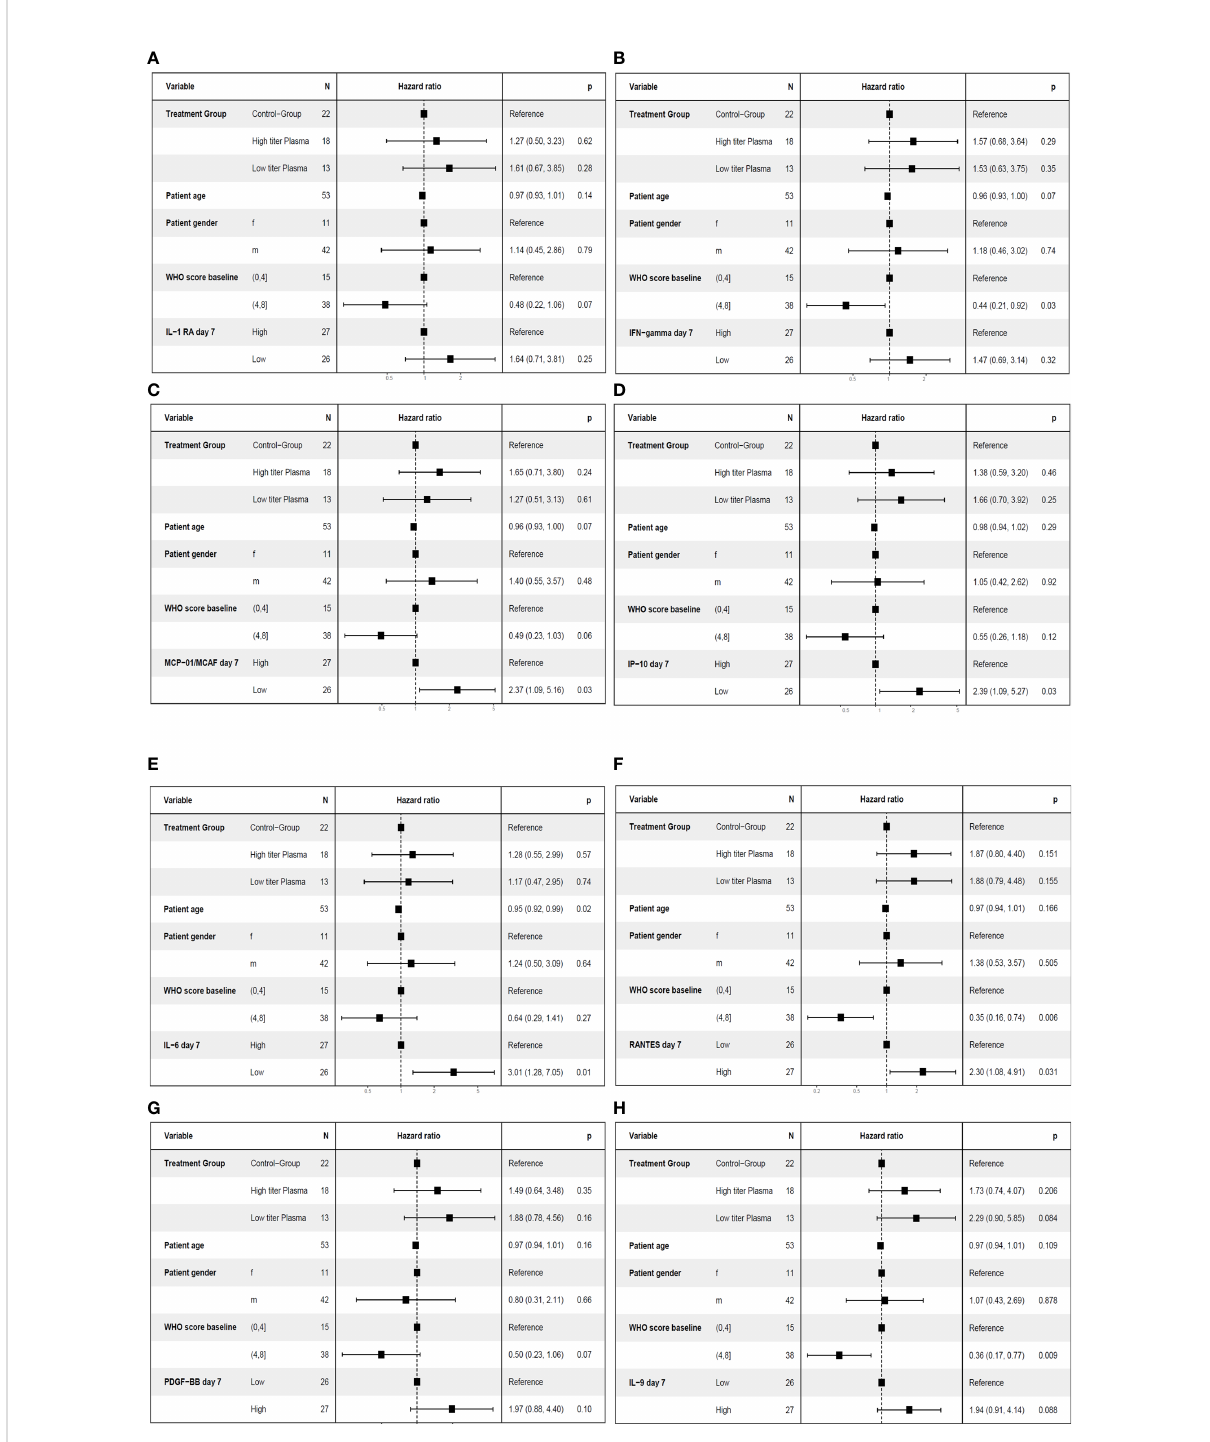
FIGURE 9 Multivariate analyses of the key secondary endpoint time to clinical improvement ( ≤ median vs. > median) including cytokine levels on day 7. The following variables were included in the model: Treatment group (control group, high titer plasma, low titer plasma), age (as continuous variable), gender, baseline WHO Severity Score ( ≤ 4 vs. > 4) (11) and the level of the respective cytokine on day 7 ( ≤ median ( “ low ” ) versus > median ( “ high ” )). One cytokine each was included in the models: IL-1RA (A) , IFN- g (B) , MCP-1 (C) , IP-10 (D) , IL-6 (E) , RANTES (F) , PDGF-BB (panel G ) or IL-9 (panel H